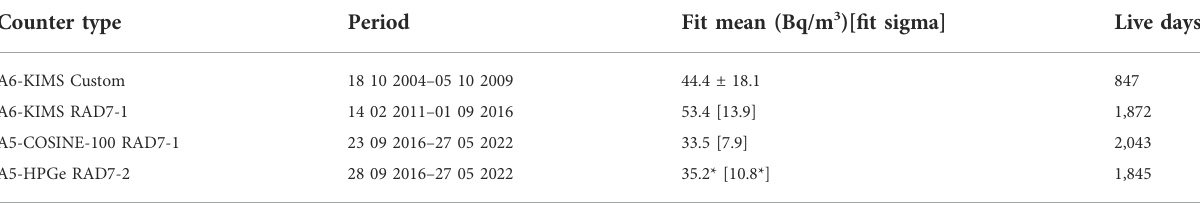
TABLE 1 The detectors and their locations are listed for all of the acquired Y2L radon data. The KIMS-Custom measurements include systematic uncertainties; those for the other measurements are only statistical uncertainties. Counter